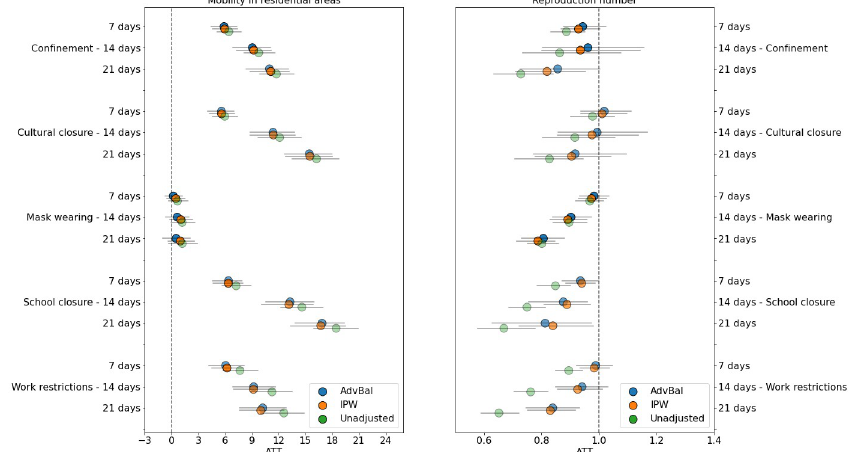
Fig 5. Estimated causal effects of NPIs over time on residential mobility (left) and reproduction number rate (right). In both plots, the opacity of the markers represents the ability of the balancing weights method to balance the treatment groups: the smaller the ASMD is, the more opaque the markers are. Fully opaque markers indicate an ASMD < 0.1, half-transparent markers indicate 0.1 � ASMD � 0.25 and most transparent ones represent ASMD > 0.25. Apart from mask wearing mandates, all NPIs caused a significant increase in time spent at home. Of those, school and cultural closures were the most effective. Closing schools, issuing face mask usage, and work-from- home mandates also caused a persistent reduction in R t after their initiation, which was not observed with the other social distancing measures. Code used for generating figure is available at https://github.com/barakm-ki/symptoms-